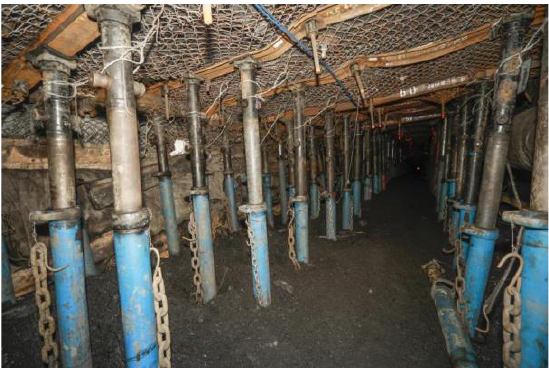
Figure 21. Overall effect of